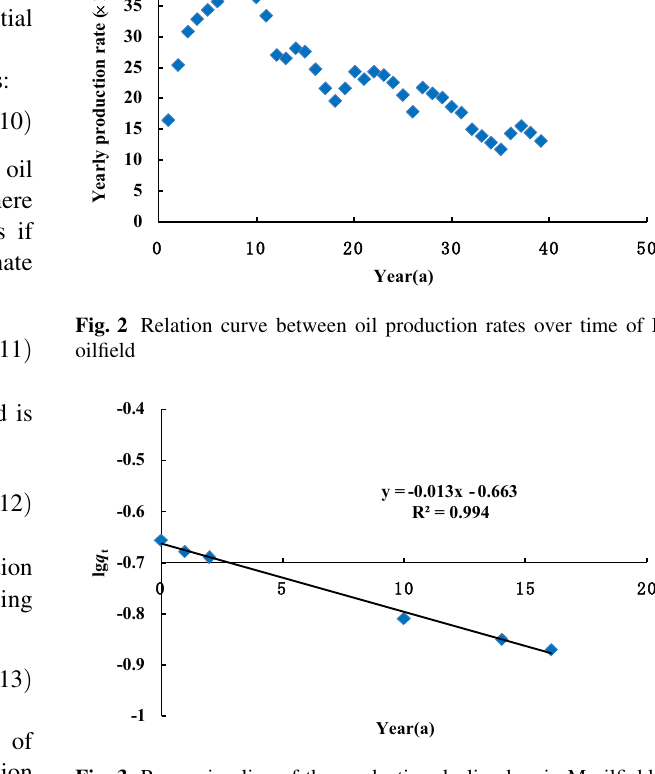
Fig. 3 Regression line of the production decline law in M